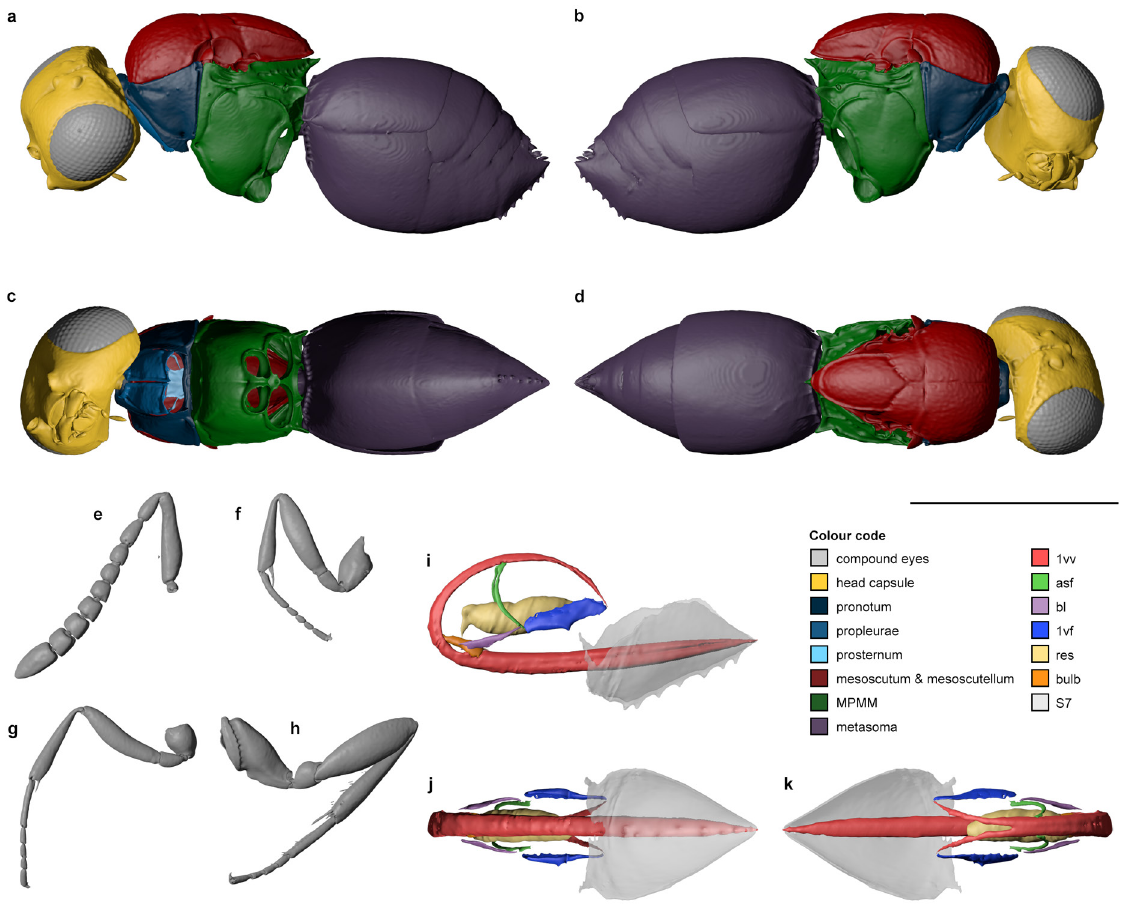
Fig. 3. Digital reconstruction of A. kretschmanni Moser sp. nov. based on synchrotron micro-CT; holotype, ♀ (SMNS_Hym_Cer_000227). a–d . Habitus in left (a), right (b), ventral (c) and dorsal (d) aspect. e .